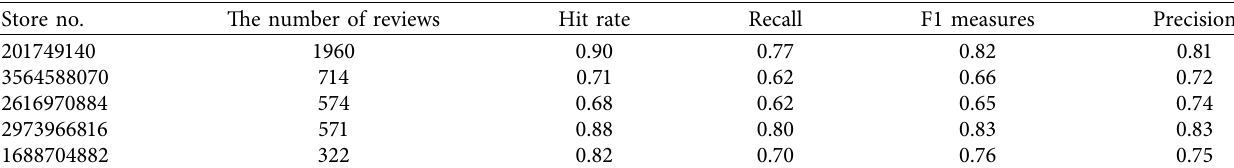
Table 1: Identification results of each store.